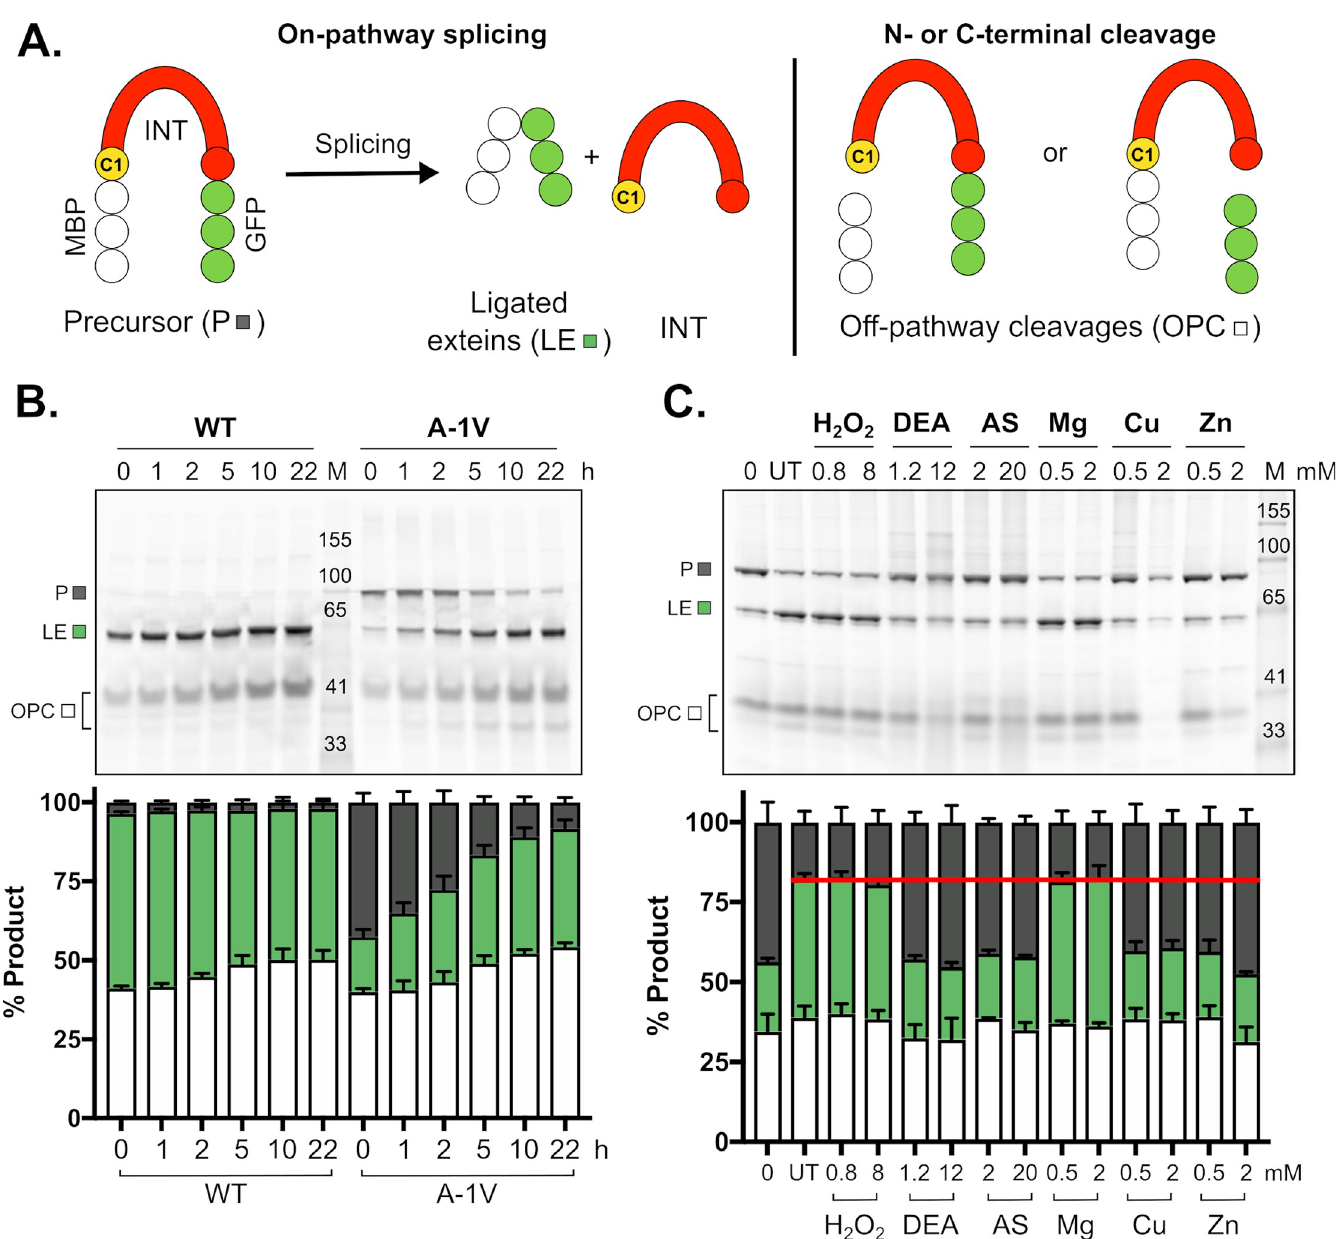
Fig 4. MIG Prp8 A-1V is responsive to metal and RNS treatment. (A) Schematic of the MIG reporter. The construct contains MIG and is expressed in E . coli . GFP allows monitoring of splicing using in-gel fluorescence. The P can undergo protein splicing (left), yielding LE and free INT (not seen on gels). OPC reactions (right), such as N- and C-terminal cleavage, can also occur. The catalytic cysteine, C1, is labeled. (B) MIG Prp8 WT splices rapidly. A fluorescent gel of a splicing time course shows that the WT Cne Prp8 intein in MIG is entirely spliced by the start of the assay (left, WT, 0 h). The A-1V mutant had precursor at the assay start and spliced over time (right, A-1V, 0 h). Quantitation is shown below in stacked plots. Data are representative of 3 biological replicates and mean standard deviations are shown. Data available in S1 Data. (C) MIG Prp8 A-1V accumulates precursor under RNS and metal treatment. After 5 h in vitro treatment with a panel of environmental stressors, there was an increase in P compared to the UT (red line) with the RNS compounds DEA at 1.2 mM and 12 mM and AS at 2 mM and 20 mM, and the metals Cu and Zn at 0.5 mM and 2 mM. H 2 O 2 and Mg showed no effect at either concentration. Quantitation is shown below in a stacked plot. Data are representative of 3 biological replicates and mean standard deviations are shown. Data available in S1 Data. AS, Angeli’s salt; Cne , C . neoformans ; DEA, DEA NONOate; GFP, green fluorescent protein; INT, intein; LE, ligated exteins; MBP, maltose-binding protein; MIG, MBP-Intein-GFP; OPC, off-pathway cleavage; P, precursor; Prp8, pre-mRNA processing factor 8; RNS, reactive nitrogen species; UT, untreated; WT, wild type.